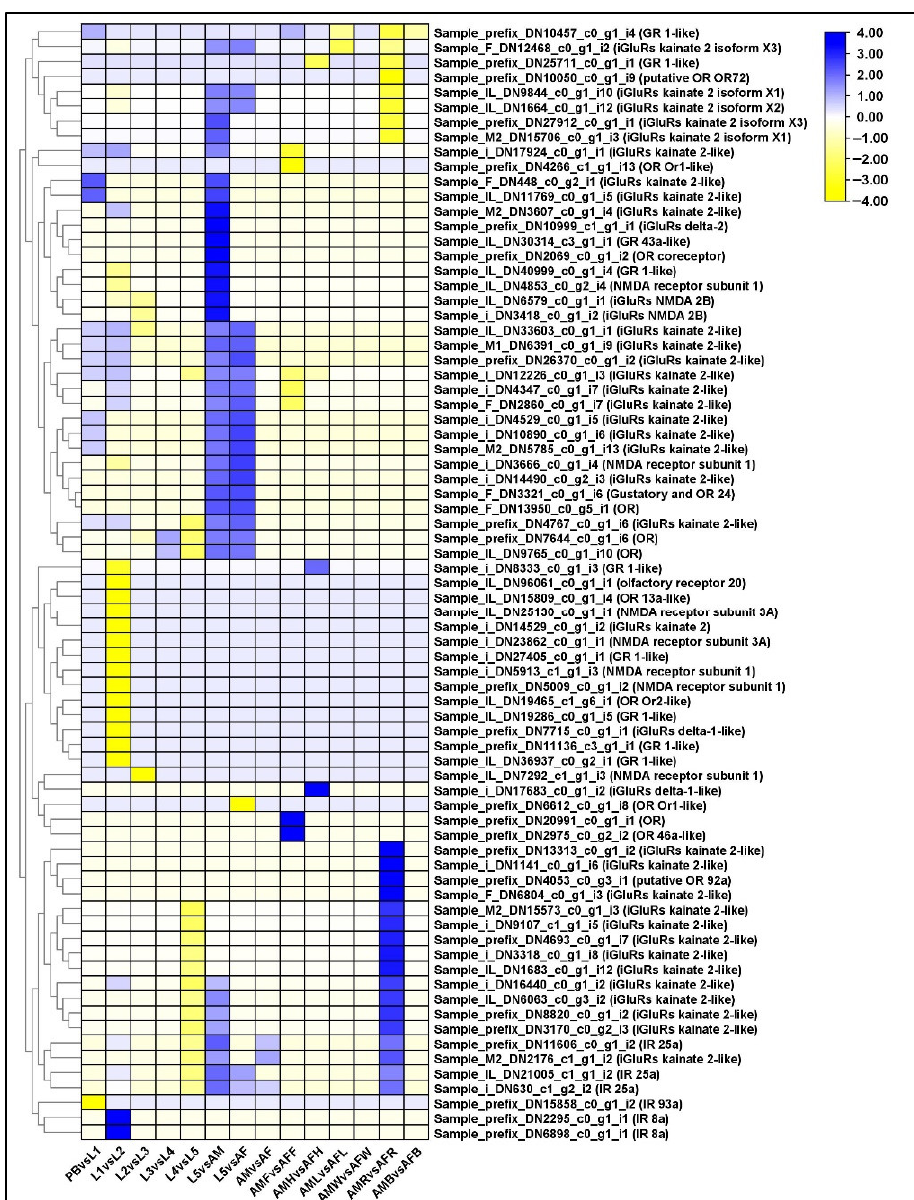
Figure 7. Identification of genes assigned to the Sensory receptors in the P. bremeri transcriptome. Heatmap representation of the differentially expressed genes of Sensory receptors.